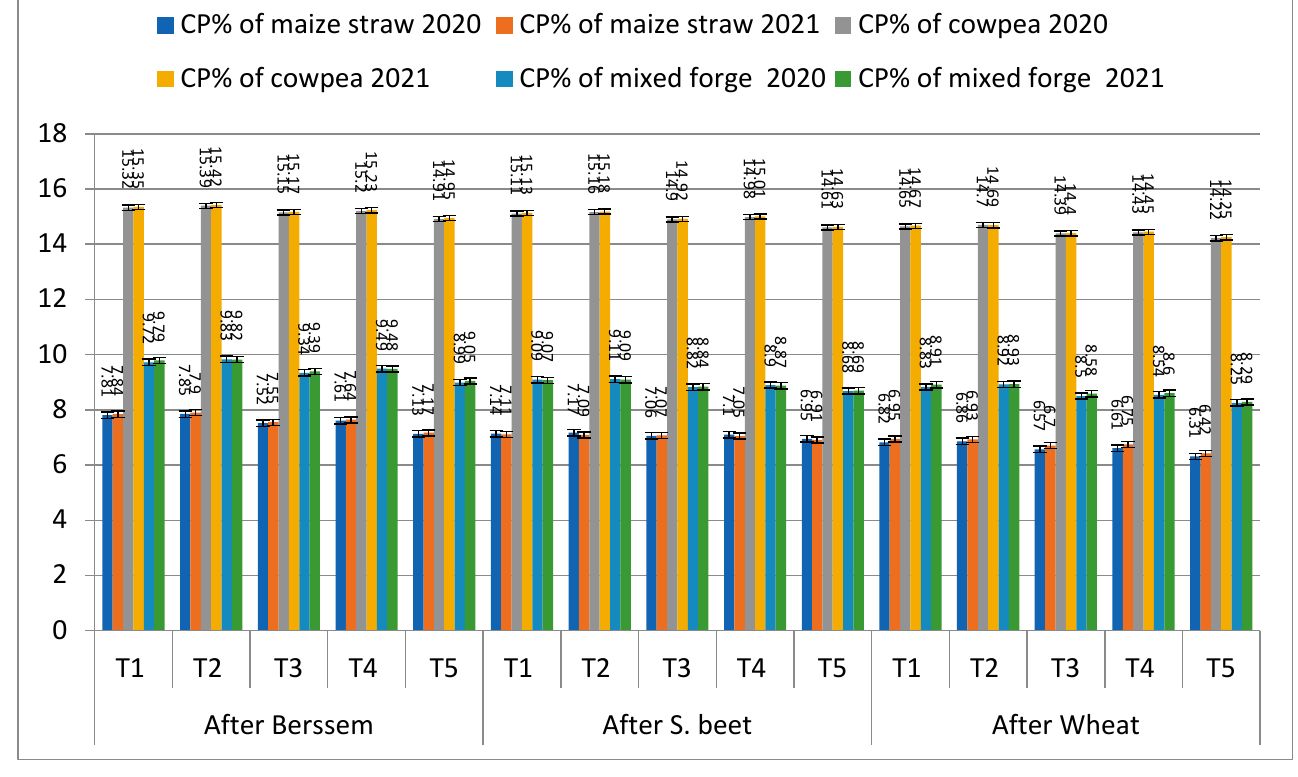
Figure 4. The effect of preceding crops and NPK as well as biofertilizers on the crude protein percentage of maize straw intercropping with forage cowpea and mixed during 2020 and 2021 seasons. T1: 100% mineral NPK, T2: 75% mineral NPK + Arbuscular Mycorrhiza fungi, T3: 50% mineral NPK + Arbuscular Mycorrhiza fungi, T4: 75% mineral NPK + Mycrobein, T5: 50% mineral NPK +